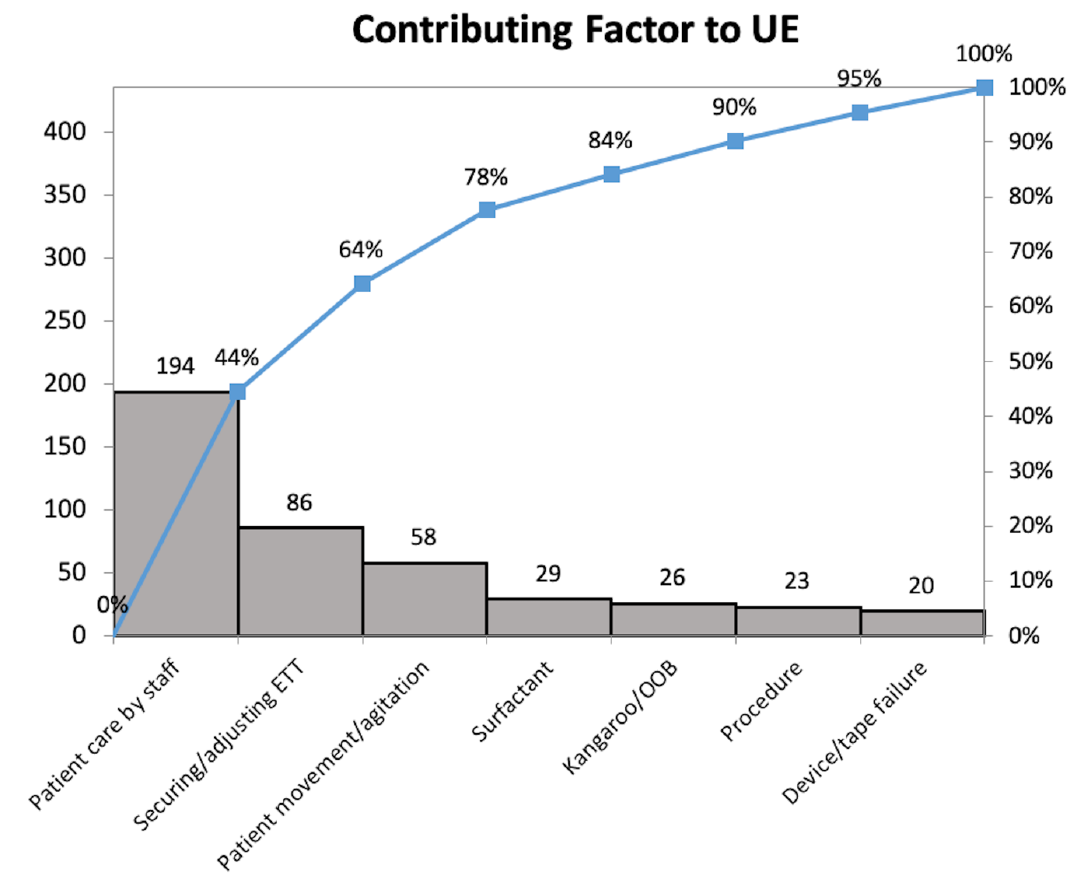
Figure 7. Pareto chart demonstrating the relative contribution of various factors for UEs among all four centers for the first 18 months of the collaborative. ETT = endotracheal tube and OOB = out of bed. The patient outcome following a UE event varied between the RPCs. At RPCs B and D, the majority of infants required re-intubation shortly after a UE, whereas at RPCs A